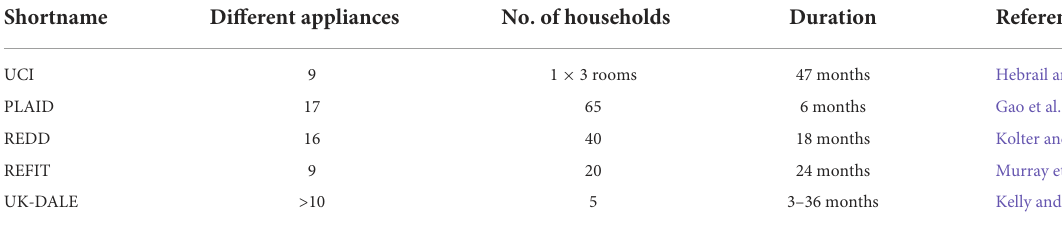
TABLE 3 The main features of the UK-DALE